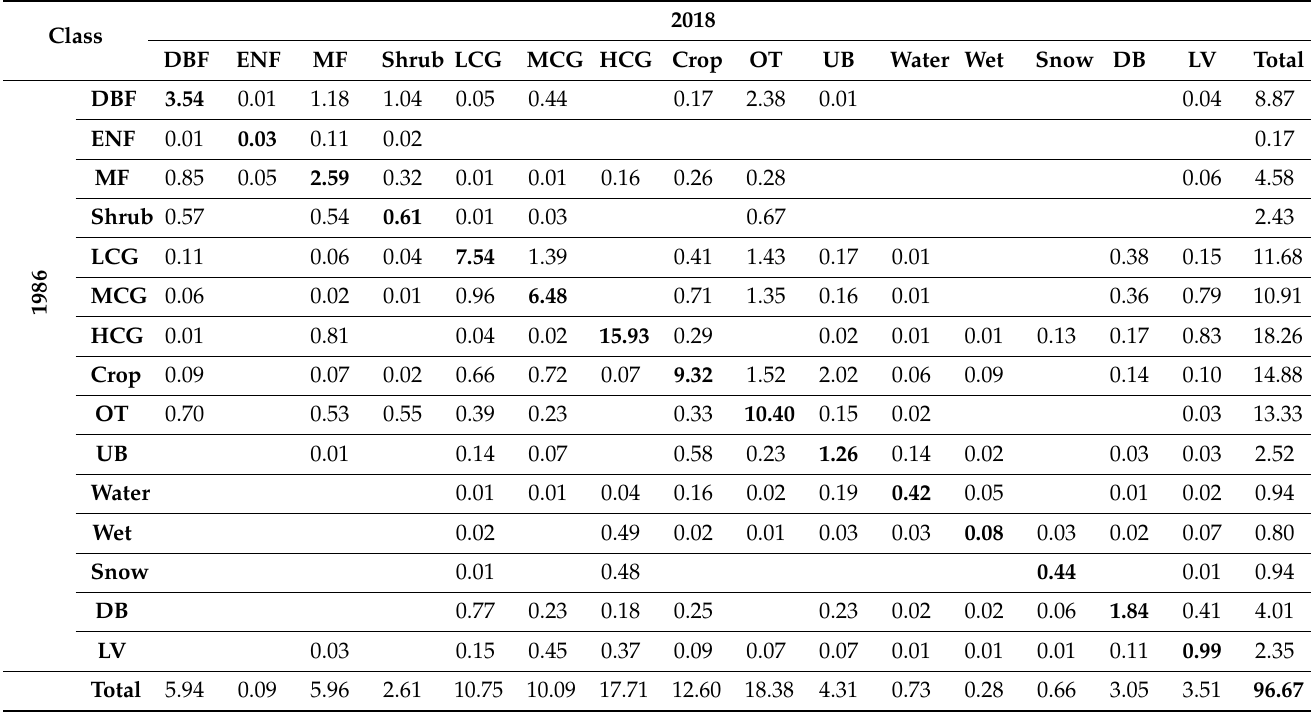
Table 4. Land use/cover transition matrix of the study area. Cell values represent the area (10 4 km 2 ) of land use/cover transitions from 1986 to 2018, and bold numbers represent correctly classified